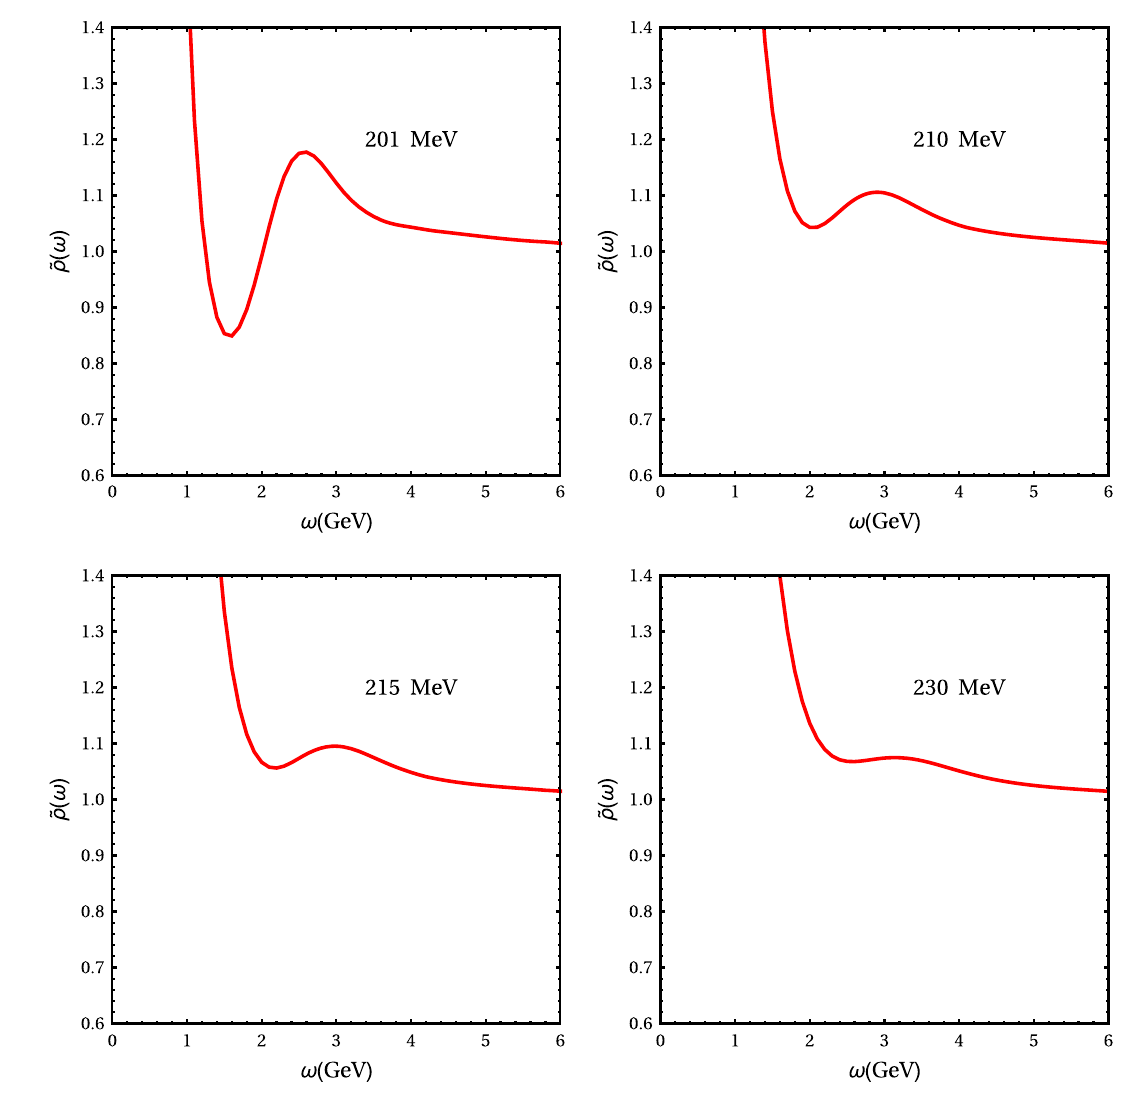
Fig. 5 Rescaled spectral function as a function of the energy ω in GeV